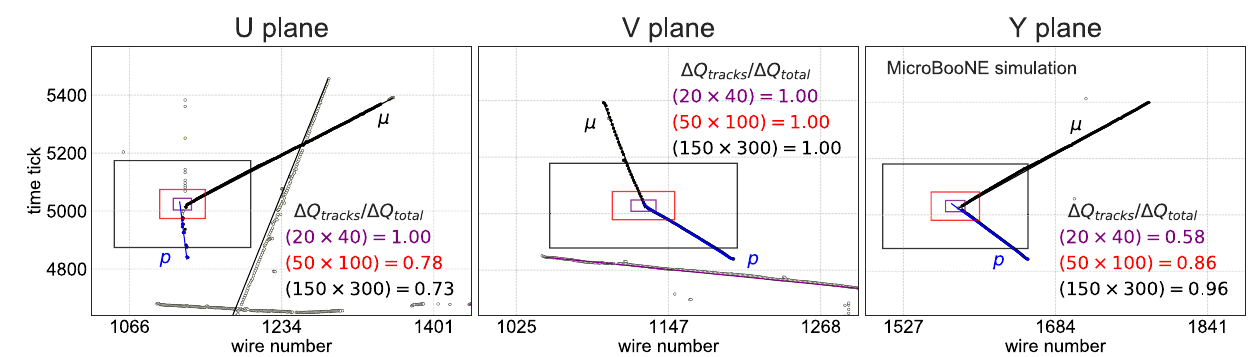
Fig. 7 A typical CC1 p 0 π event with cosmic activity overlaid in MicroBooNE data. Shown are three boxes of different dimensions ( N w ires × N ticks ), and the ratio R Δ Q for each, in the two induction